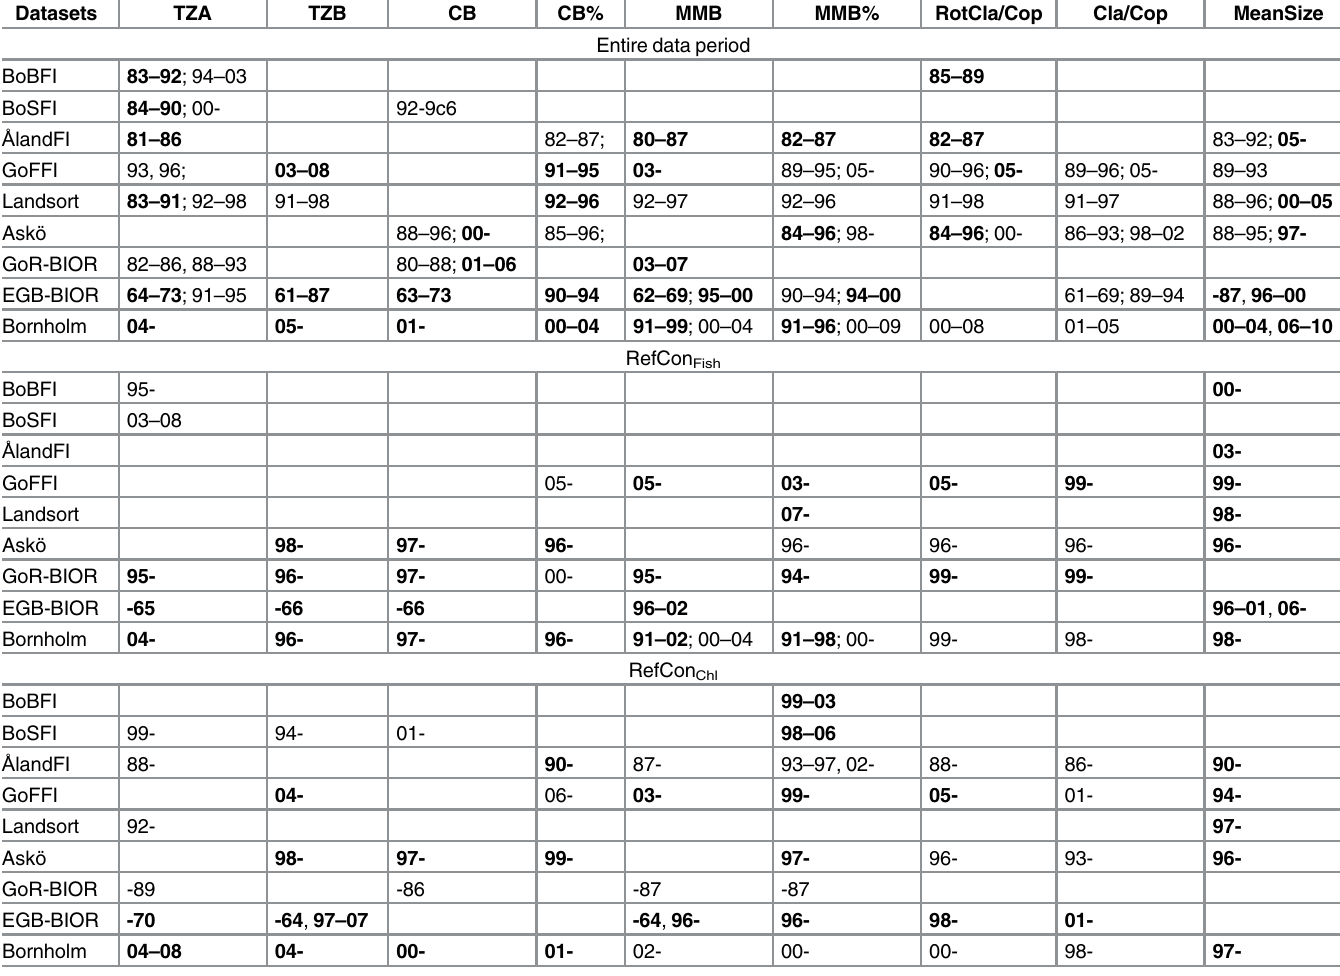
Table 3. Summary of CuSum analysis (S3 Fig) for all indicators and datasets with > 12 years of observations. Periods when UCL or LCL (bold) were violated for > 3 consecutive years are shown; the first two digits are omitted for